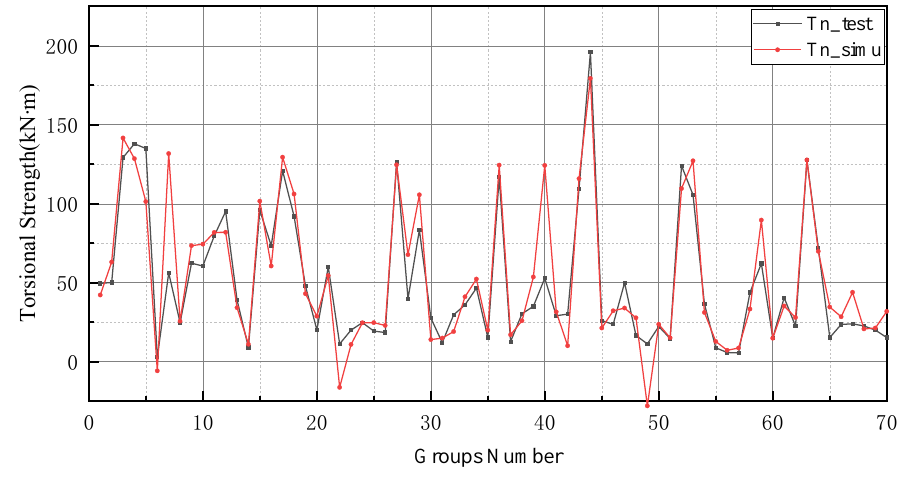
Figure 9. Prediction results of GA-BP neural network.